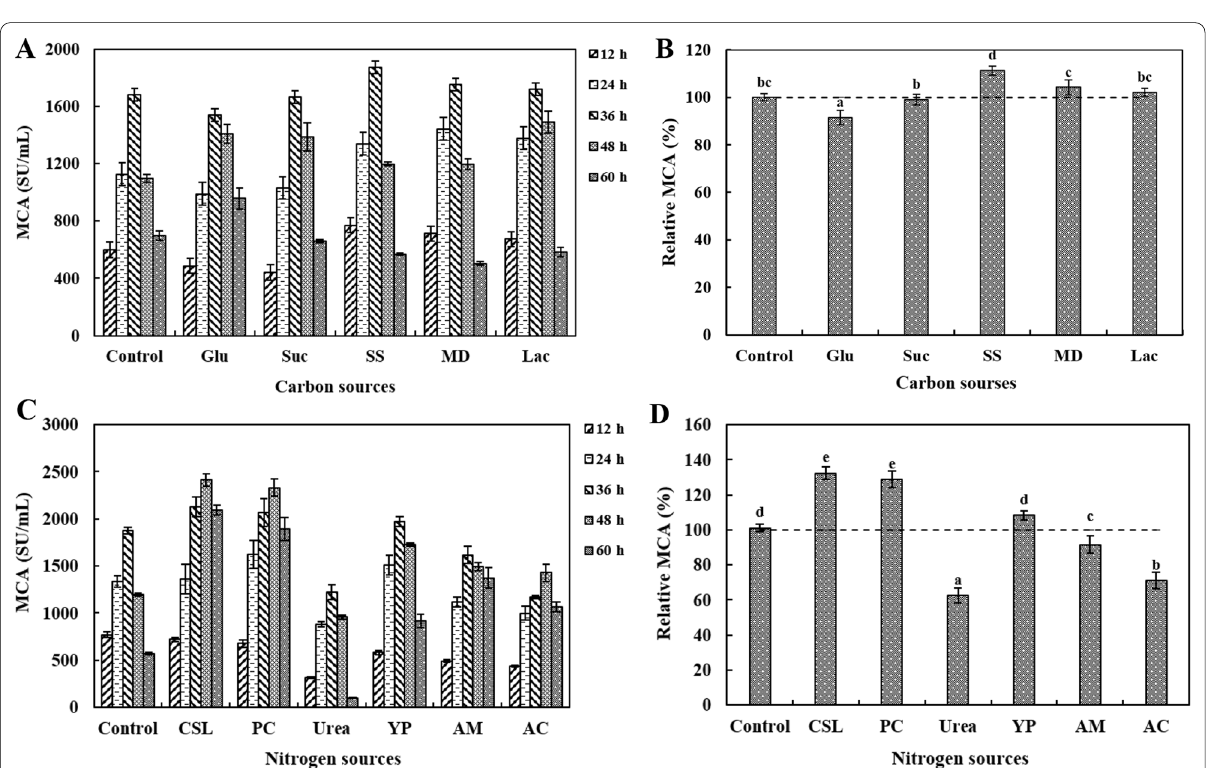
Fig. 4 The effects of different kinds of carbon sources on DB219 MCE production during fermentation (12–60 h) ( A , B ). Glu, glucose; Suc, sucrose; SS, soluble starch; MD, Maltodextrin and Lac, Lactose. The effects of different kinds of nitrogen sources on DB219 MCE production during fermentation (12–60 h) ( C , D ). CSL, corn steep liquor; PC, casein peptone; YP, yeast extract powder; AM, ammonium sulfate and AC, ammonium citrate. a − e Values in the same row with different superscripts are significantly different ( P < 0.05). The data are represented as mean